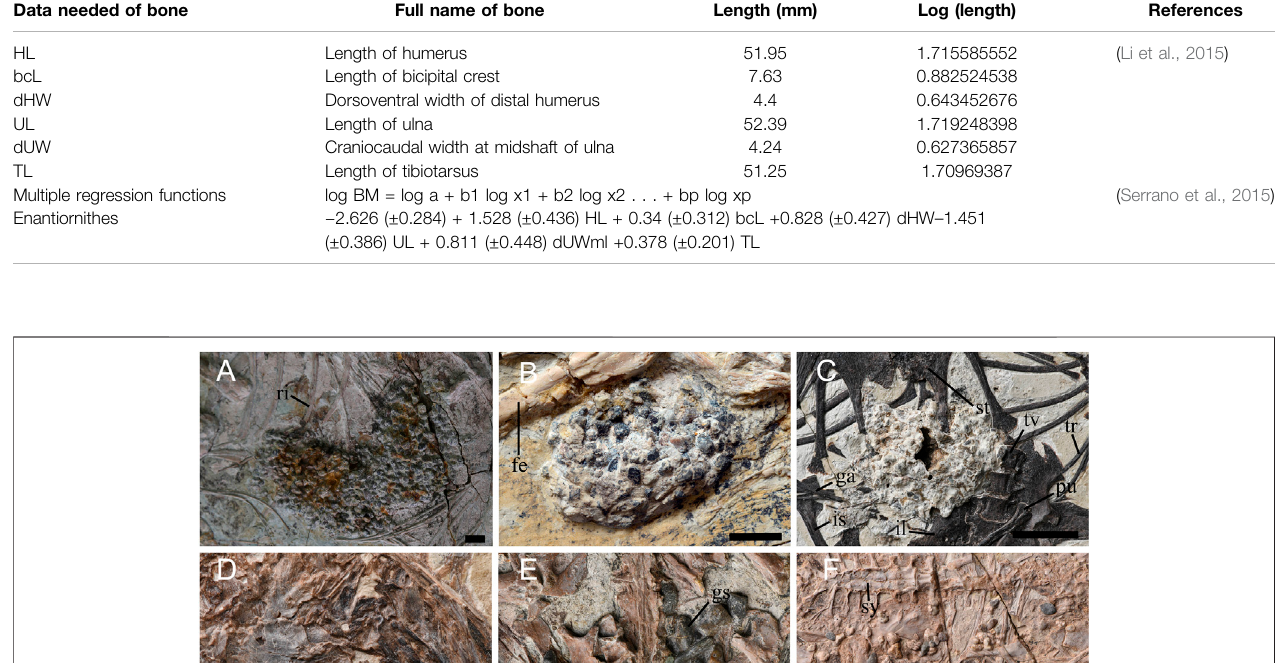
Frontiers in Earth Science |